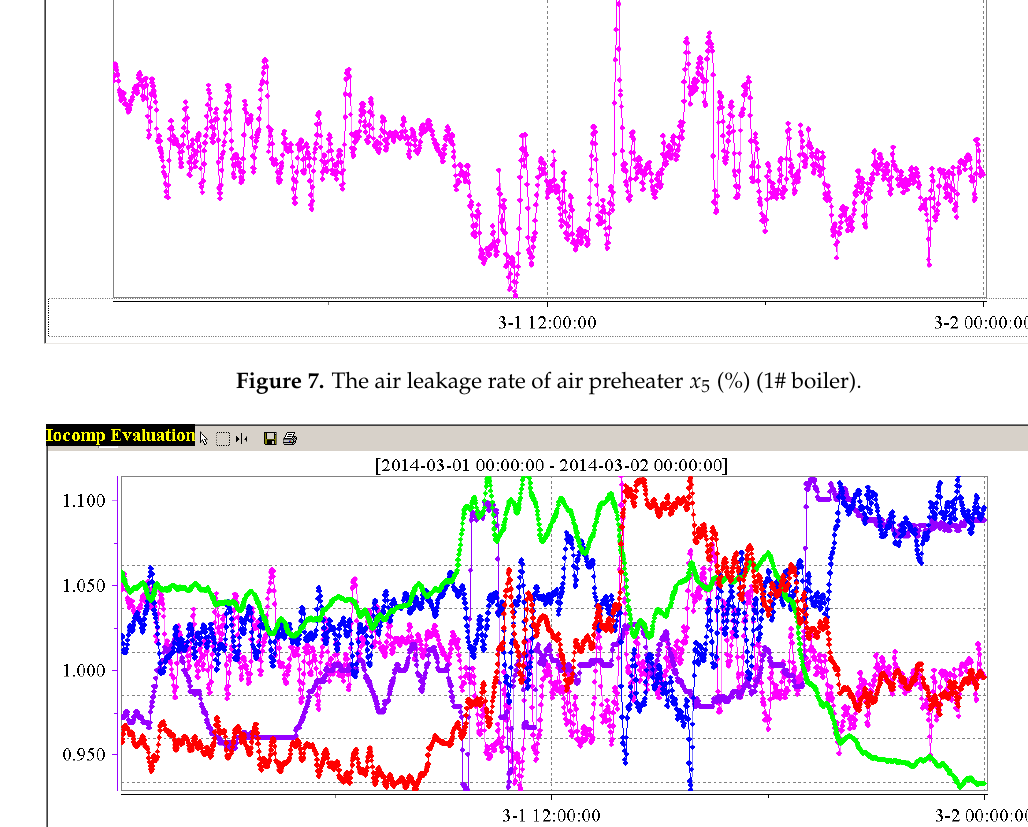
Figure 8. Five variables x 1 , x 2 , x 3 , x 4 and x 5 (1#